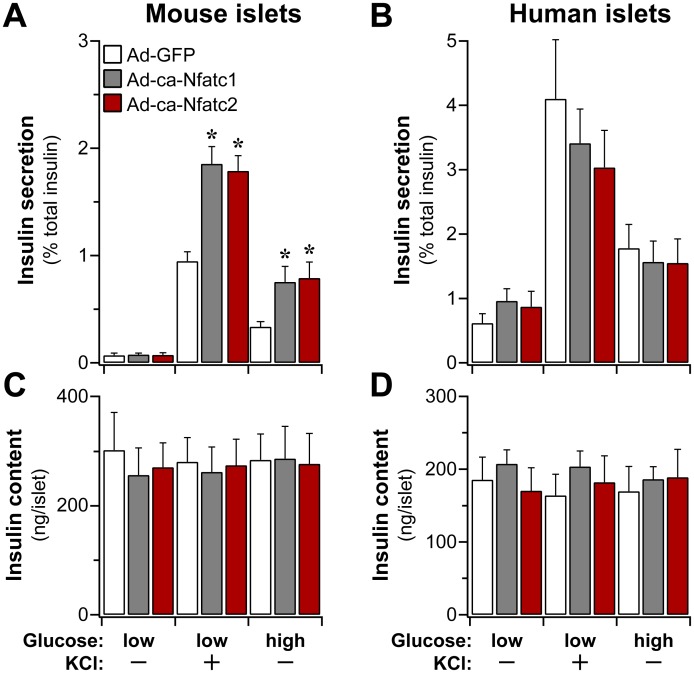
The effect of ca-NFAT on insulin secretion from mouse and human islets.Insulin secretion (A and B) and islet insulin content (C and D) were determined from mouse and human islets 72 hr after overexpression of ca-Nfatc1 or ca-Nfatc2 by adenovirus (Ad); Ad-GFP was used as the negative control. Islets were maintained in low glucose (1.7 or 3.3 mM), until changed to media containing secretagogues, as indicated. Insulin secretion was induced with high glucose (16.7 mM) or low glucose plus KCl (40 mM). Secretion is plotted as percent of total insulin present within the islets. All measurements show the mean ± SEM of N ≥ 4 independent mouse or human islet preparations. *, P < 0.05 relative to Ad-GFP.